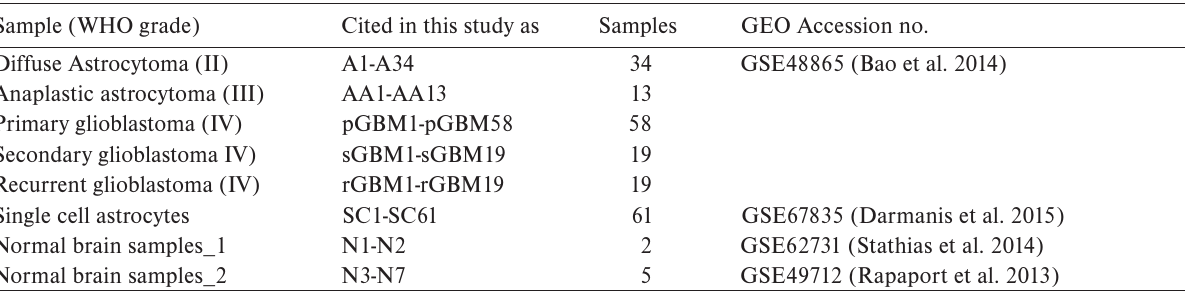
Table 1. List of samples used in this